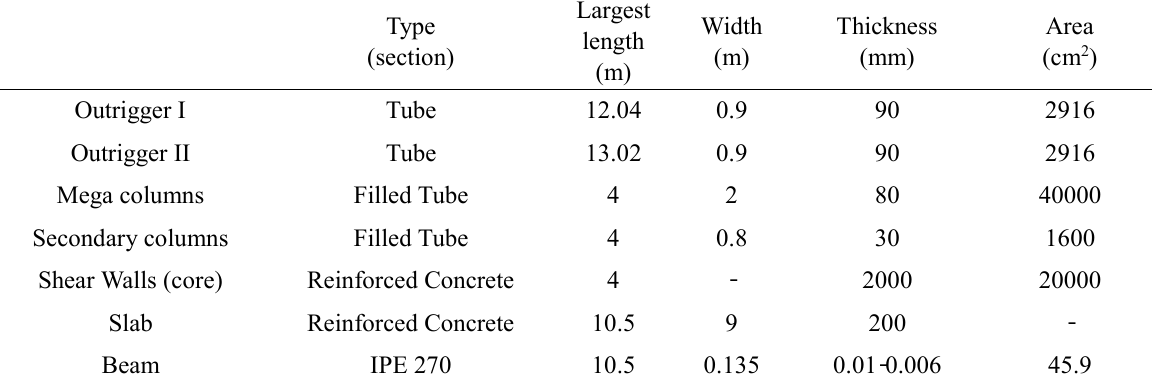
Fig. 3. Elevation with a) belt truss distribution 1, b) belt truss distribution 2, c) outrigger type I, II, distribution 2. Elements